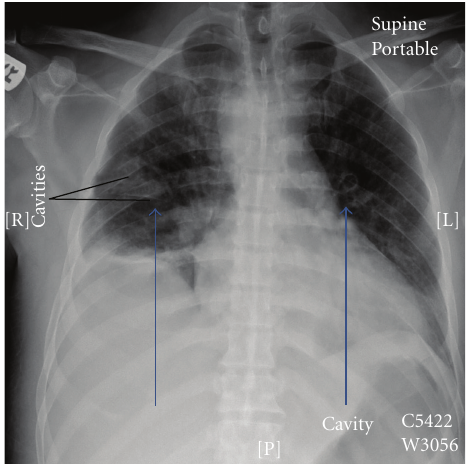
Figure 2: Chest X-ray of the chest showing multiple abscess cavities.